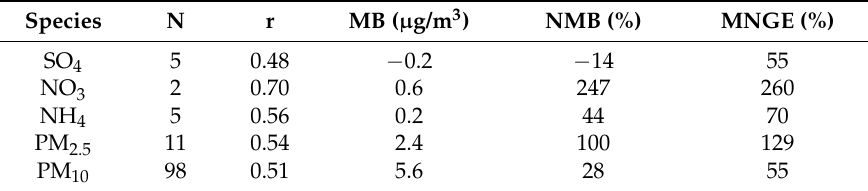
Table 4. As in Table 3, but for mean statistical indices applied to observed and modelled daily mean values at EMEP stations for SO 4 , NO 3 , NH 4 , and AIRBASE sites for PM 2.5 and PM 10 . N is the number of